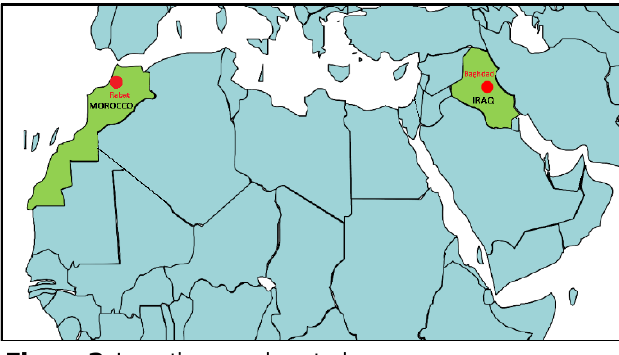
Figure 2 . Locations under